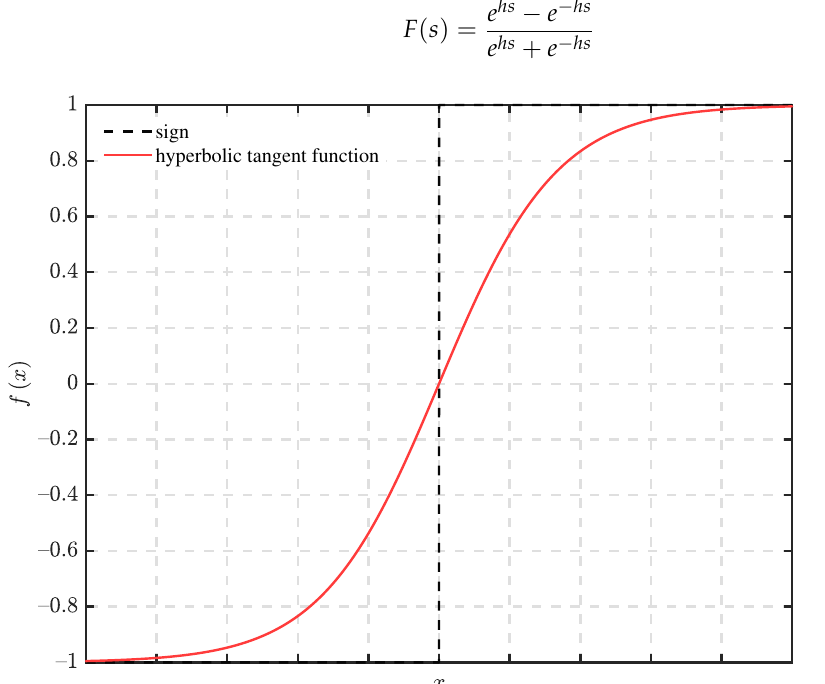
Figure 1. Sign function and hyperbolic tangent